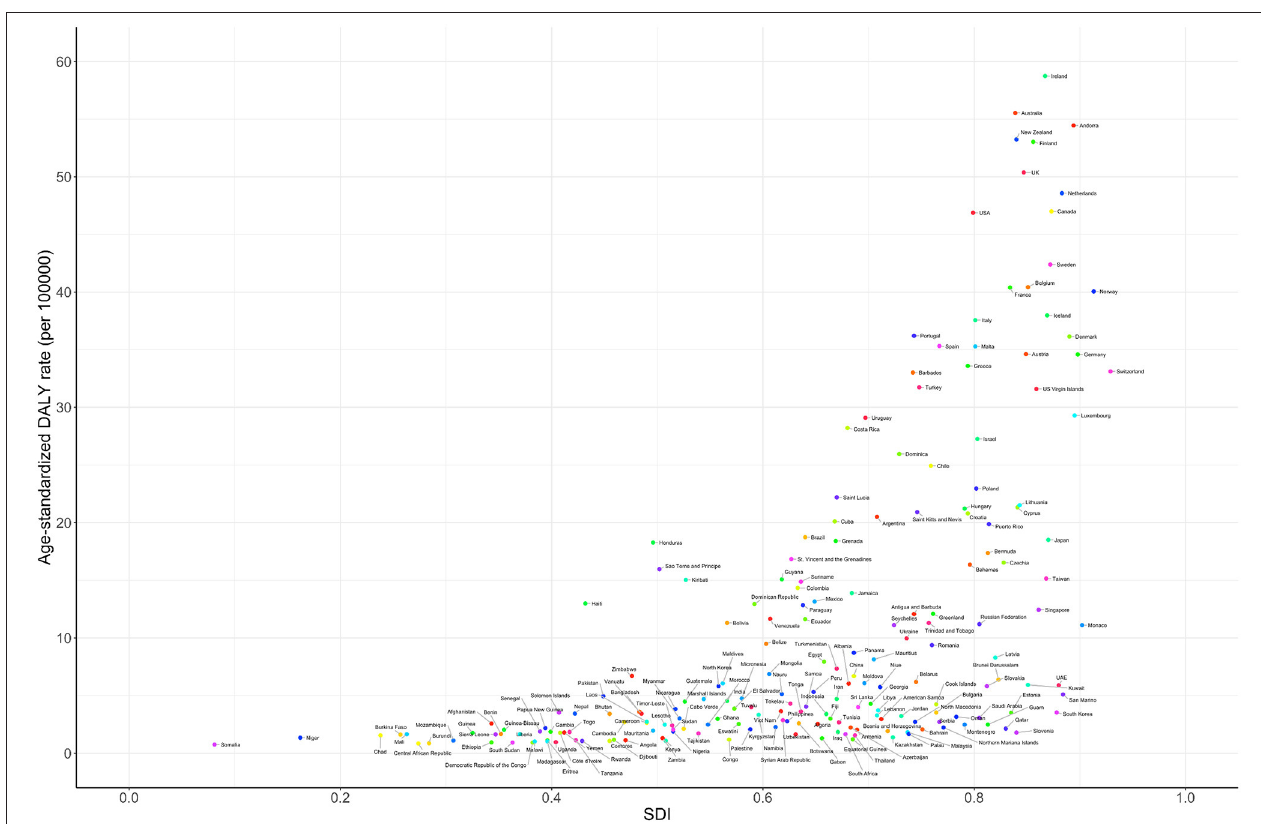
FIGURE 5 | Age-standardized DALY rate of motor neuron diseases according to country-specific sociodemographic index. Age-standardized DALY rates are presented as rates per 100,000 population. DALY, disability-adjusted life-years; SDI, sociodemographic index.